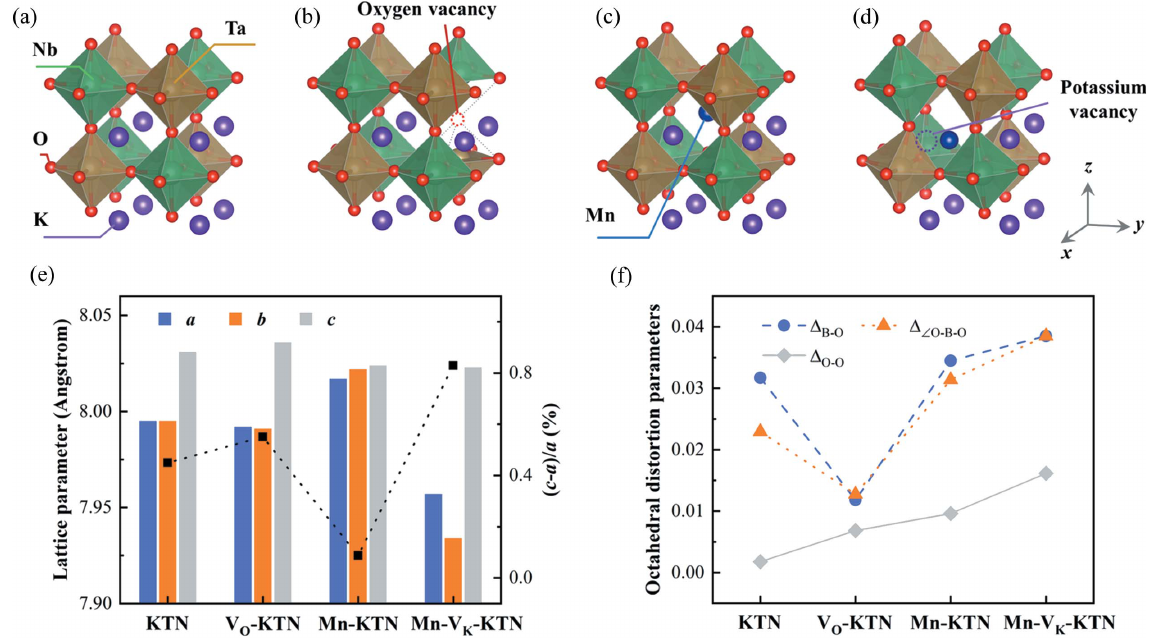
Figure 5 First-principles calculations for Mn-doped KTN. ( a )–( d ) Relaxed 2 (cid:5) 2 (cid:5) 2 supercell structures of pristine KTN, KTN with an oxygen vacancy (V O - KTN), and Mn-doped KTN without and with a potassium vacancy (Mn-KTN and Mn-V K -KTN), respectively. ( e ) Lattice parameters for the above four structures. ( f ) Octahedral distortions quantified by the relative changes in the average B—O bond length, O—B—O angle and O—O